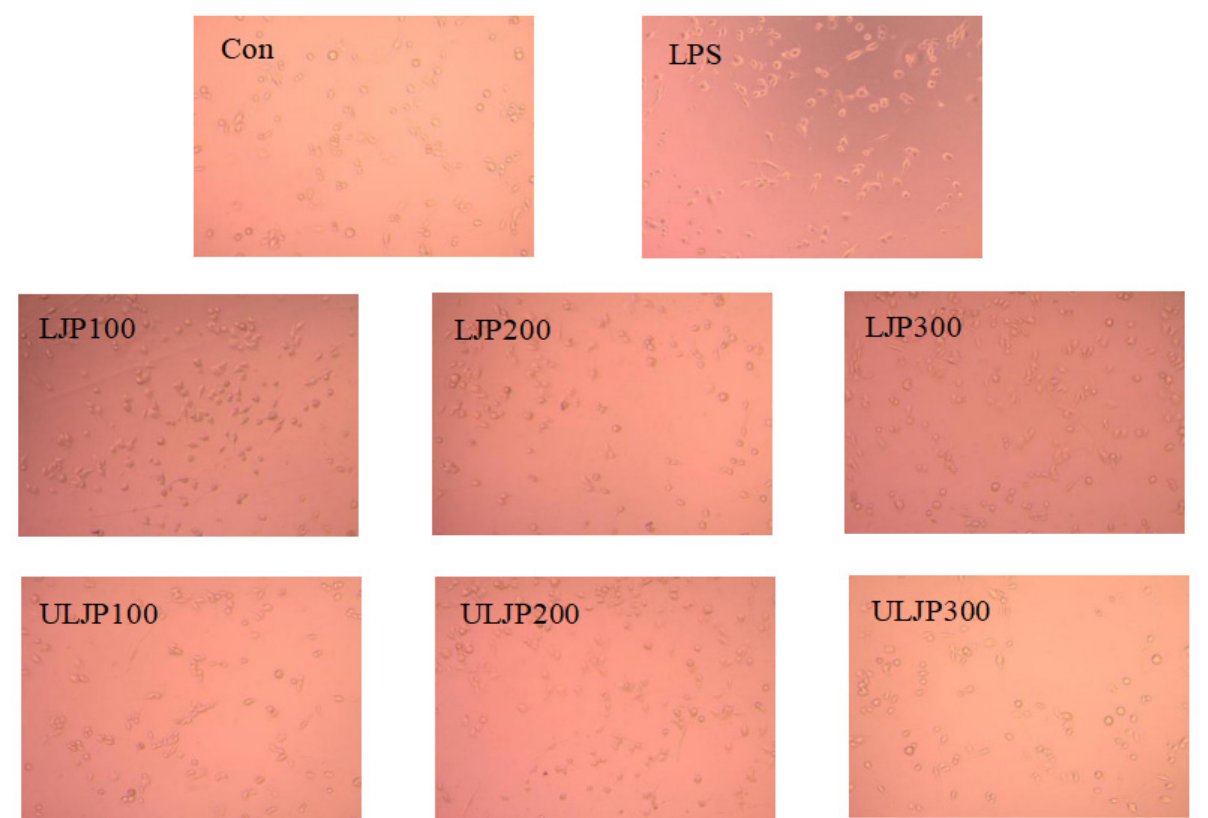
Figure 7. Effects of LJP and ULJP on the morphology of RAW264.7